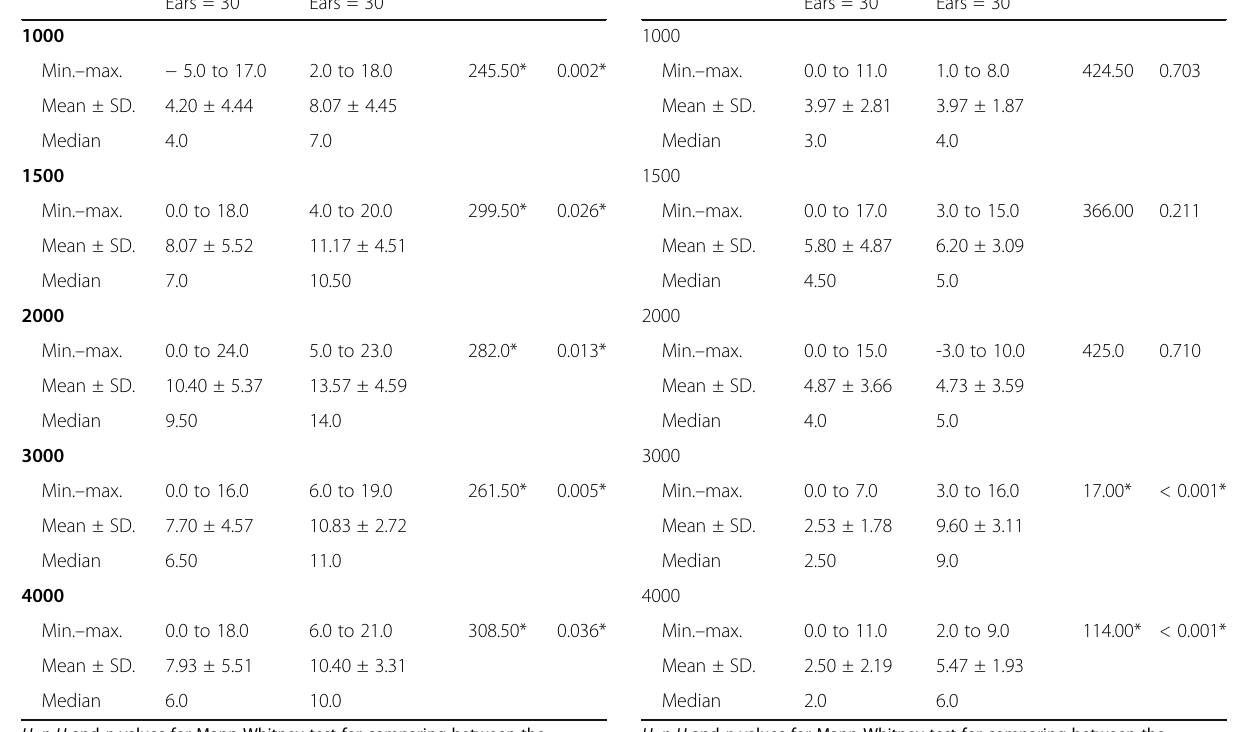
Table 6 Comparison between the two studied groups according to suppression value in TEOAE amplitudes (dB SPL) Suppression value Cases ( n = 15) Ears = 30